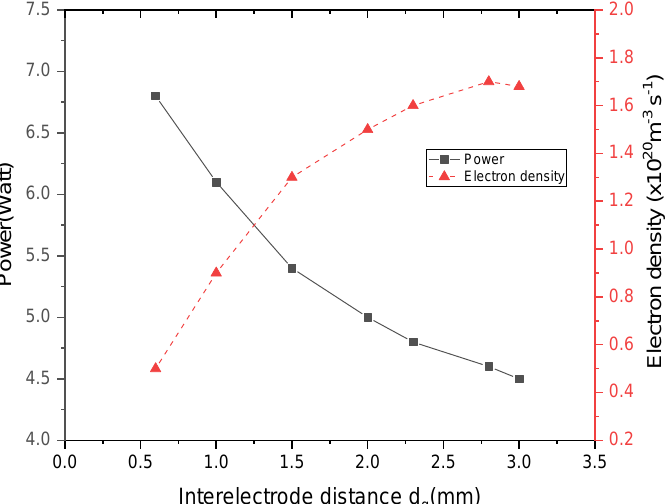
Figure 10. Evolution of electron number density N e and consumed power P with different interelec- trode distance d g .